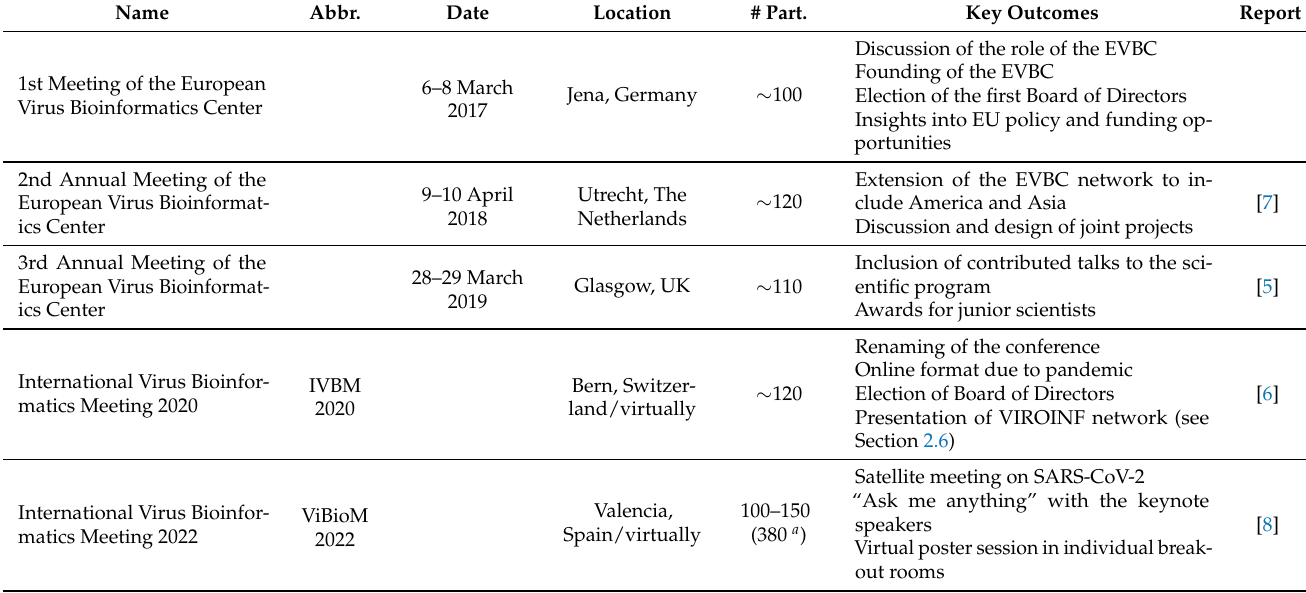
Table 2. History of the annual conference of the EVBC. The annual conference of the EVBC offers the opportunity to exchange the latest research results and experiences with an extensive network of leading experts and aspiring young scientists in both areas and engage in inspiring